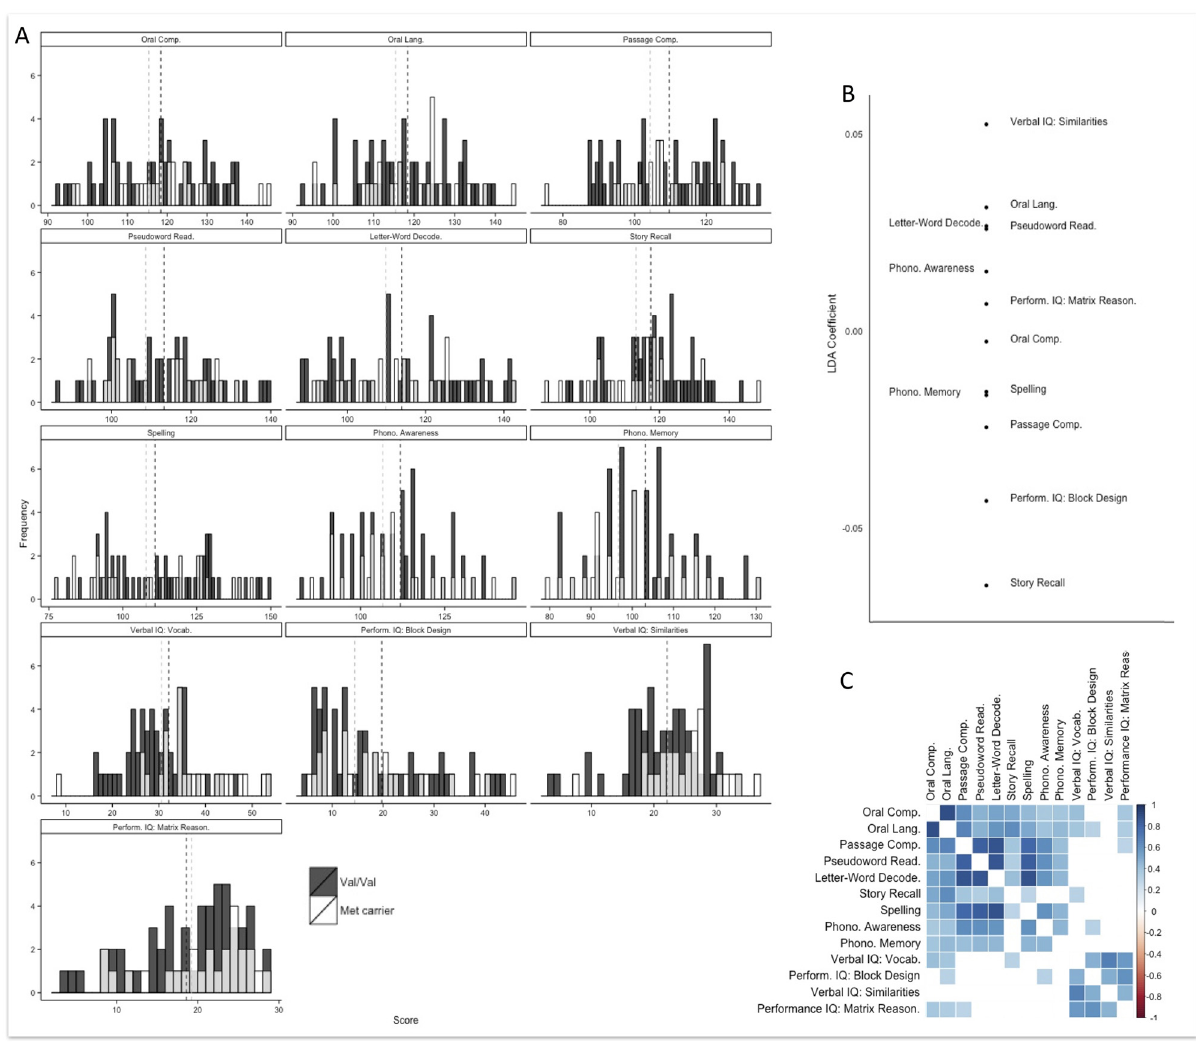
Fig 3. Behavioral Results. (A) Histograms of scores for each behavioral assessment, by group. Group means are indicated on each plot (B) Coefficients of linear discriminant function to classify individuals according to genotype group. Similar coefficients are shown for phonological memory, passage comprehension, block design, and story recall. (C) Significant correlations (p < .004) between behavioral